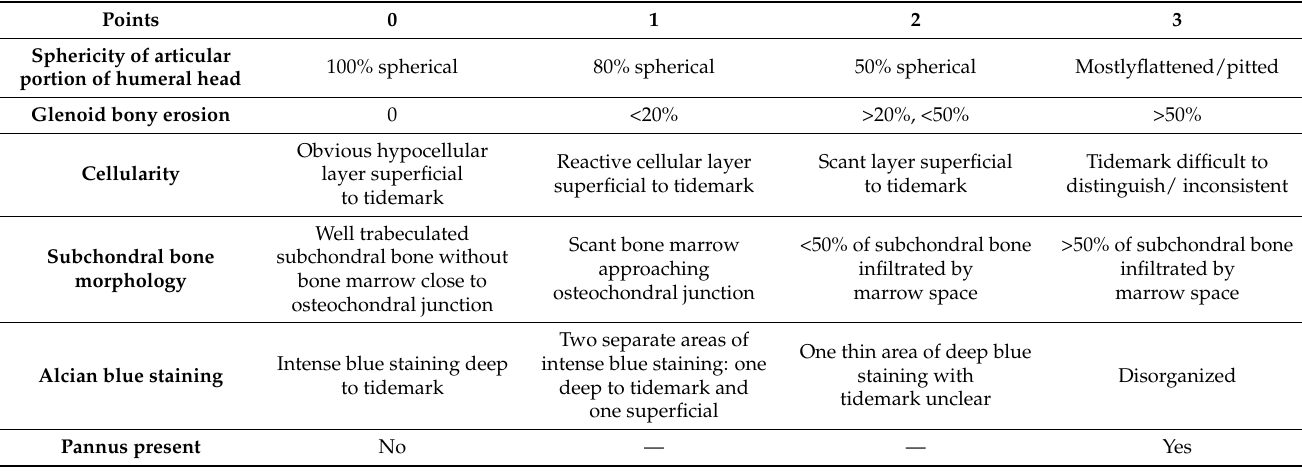
Table 1. Shoulder osteoarthritis according to the histopathologic scoring system. The table was adapted from the study by Zingman et al.